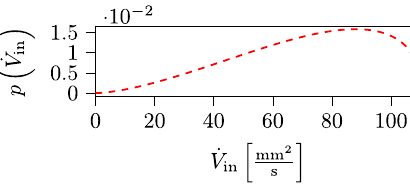
(cid:2) (cid:3) ˙ V of assumed uncertain inflow volume rate ˙ V in